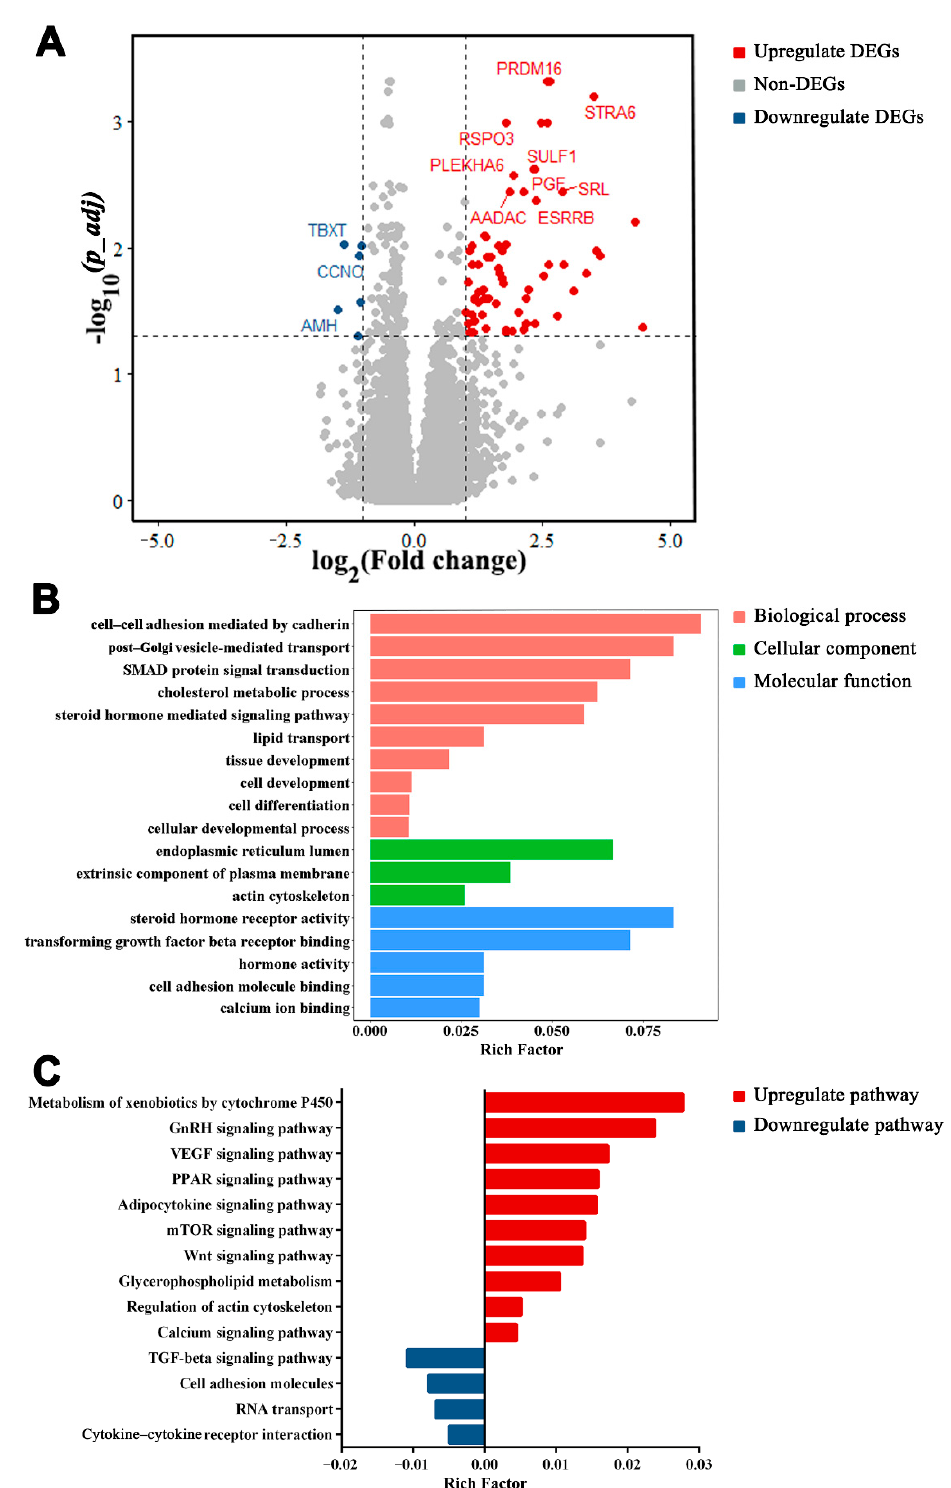
Figure 6. Differentially expressed genes (DEGs) in large white follicles (LWF) vs. small yellow follicles (SYF). ( A ) Volcano map of DEGs in LWF vs. SYF. DEGs with p_adj < 0.05 and log fold change ≥ 1 are marked in red, and DEGs with p_adj < 0.05 and log fold change ≤ − 1 are marked in blue. ( B ) Gene Ontology functional classification of DEGs in biological process, cellular component, and molecular function categories. ( C ) Kyoto Encyclopedia of Genes and Genomes pathways of DEGs.